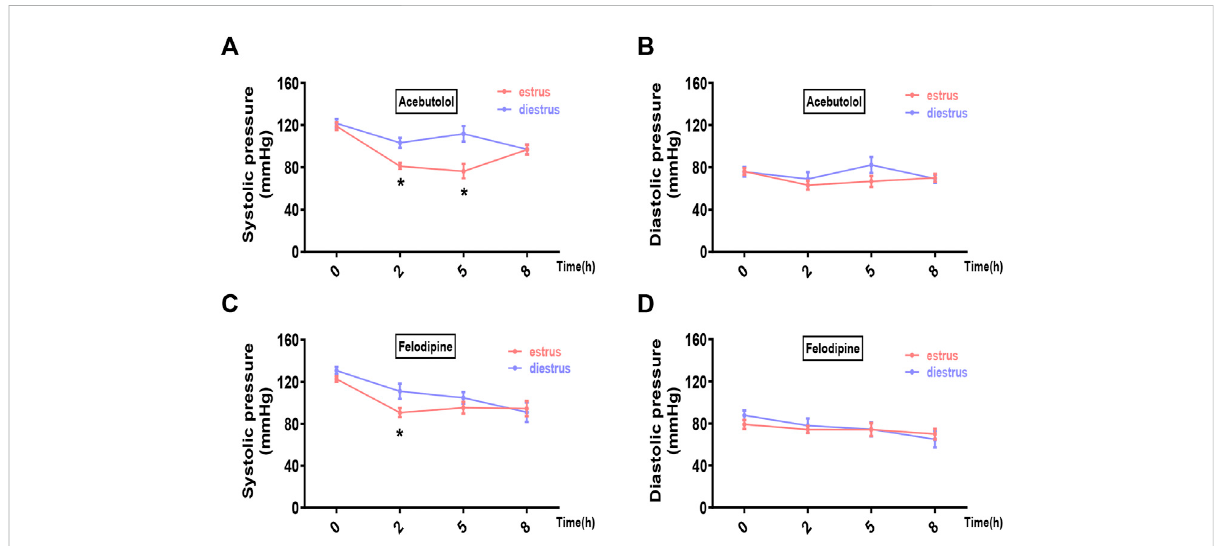
FIGURE 5 Acebutolol and felodipine exert stronger hypotensive effects on hypertensive mice in estrus than in diestrus. Hypertensive female mice were constructed via the subcutaneously infusion of angiotension-II for 2 weeks. Mice in estrus and diestrus were orally treated with acebutolol (2 mg/kg body weight) and felodipine (5 mg/kg body weight), respectively, and then blood pressure levels were monitored inthefollowing 8 h(0, 2, 5,8 h) (A) Systolic blood pressure and (B) diastolic blood pressure after acebutolol treatment (C) Systolic blood pressure and (D) diastolic blood pressure changes after felodipine treatment. p -values were determined by two-way ANOVA followed by Bonferroni correction, the values ≤ 0.05 were considered statistically signi fi cant. N = 8, * p -value ≤ 0.05.